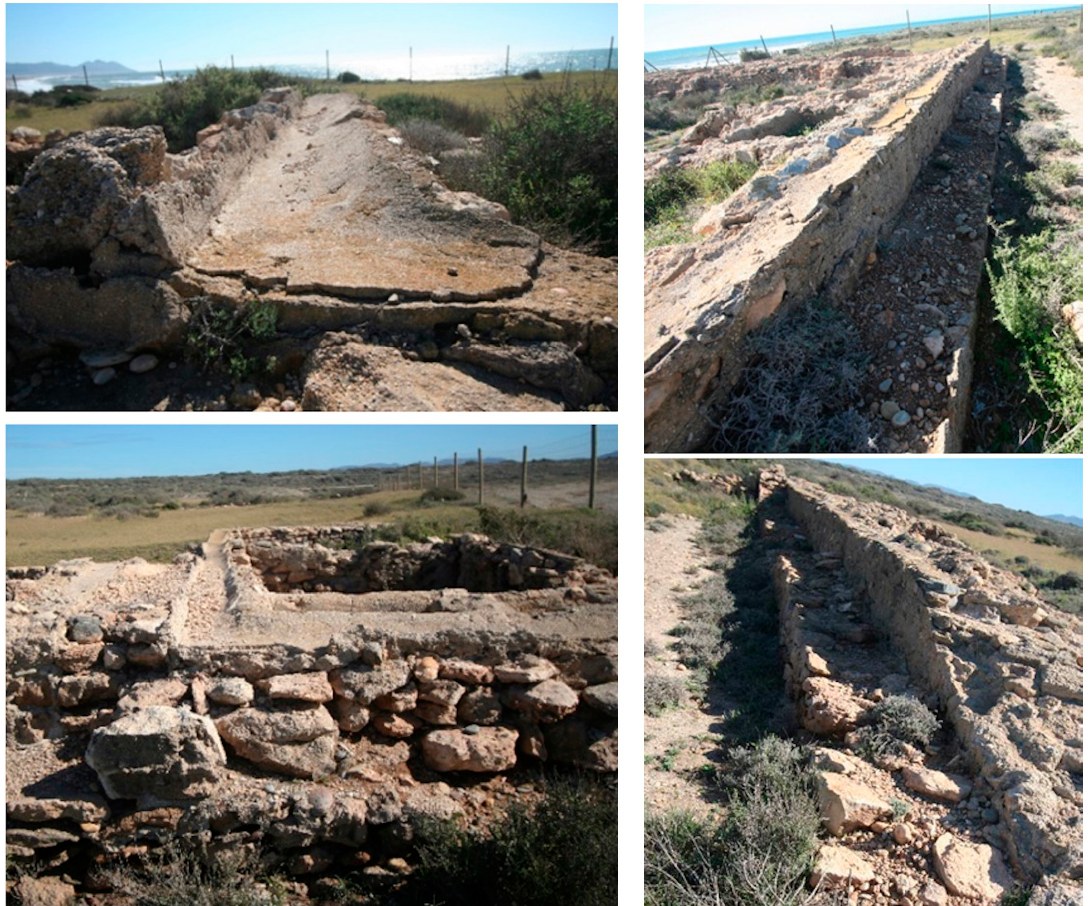
Figure 5. Construction details of the lacus or Basins and overflow spillways.